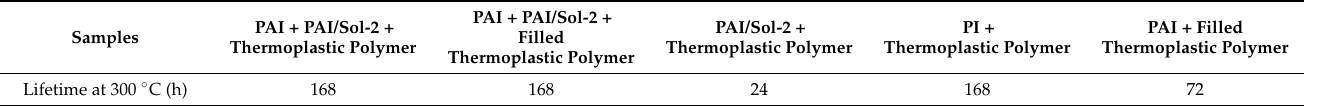
Table 5. Lifetime at 300 ◦ C aging